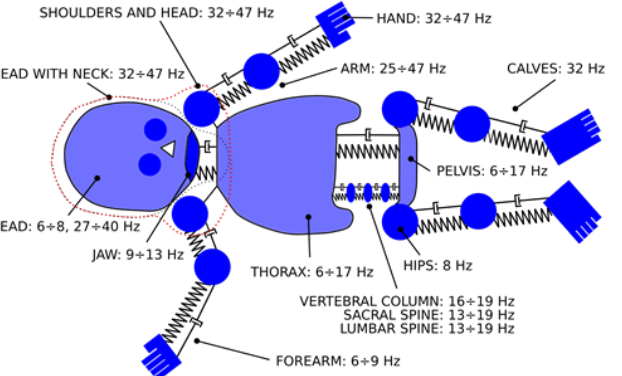
Figure 6. Examples of ranges of the natural frequencies of a child’s body parts vibrations on the basis of data from [32].